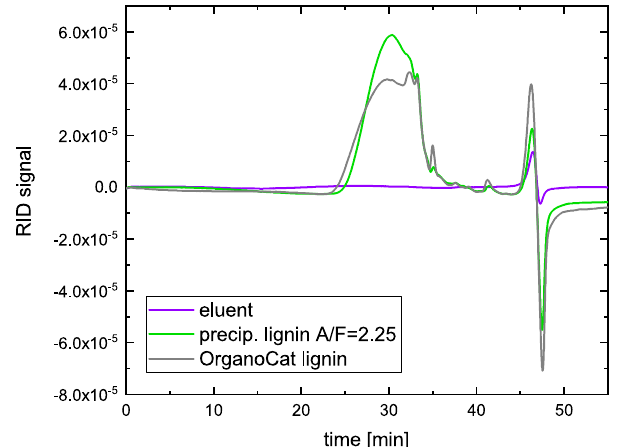
Figure 2. Size exclusion chromatography (SEC) chromatograms for OrganoCat lignin before and after precipitation from a 10 wt% solution in 2-MTHF with n- hexane. Eluent flow rate at 1 mL min − 1 .